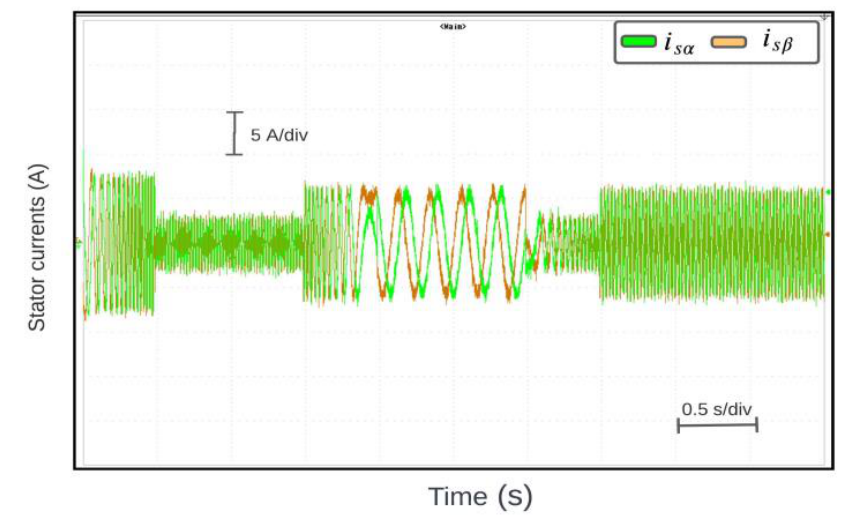
Figure 11. The stator currents in α-β frames.